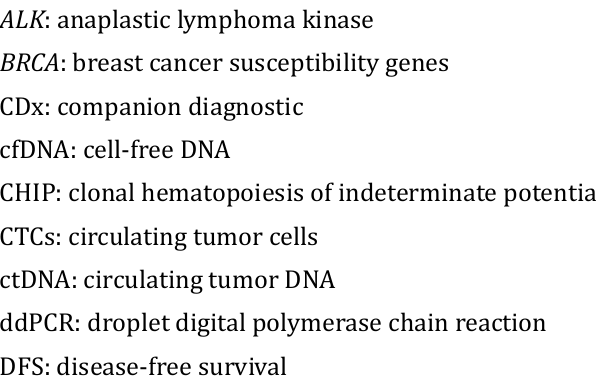
CTCs: circulating tumor cells ctDNA: circulating tumor DNA ddPCR: droplet digital polymerase chain reaction DFS: disease-free